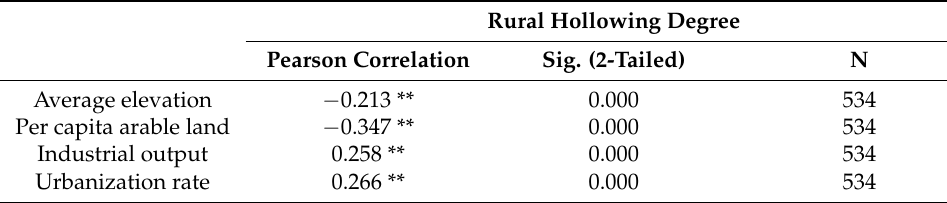
Table 7. Correlation of influencing factors of rural hollowing in Sichuan